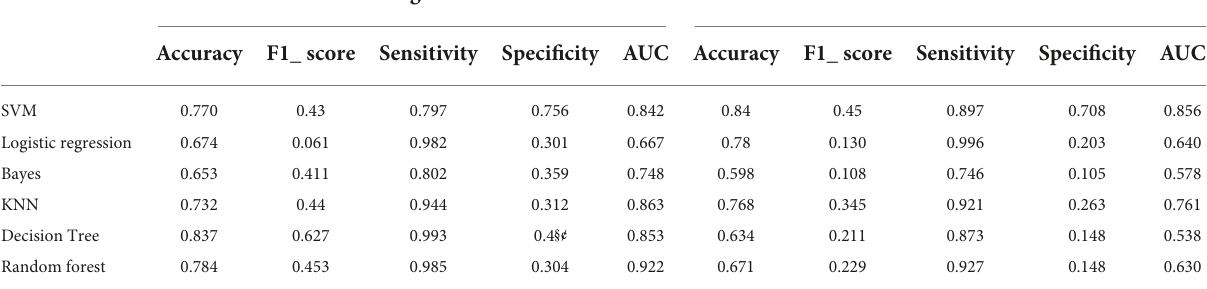
TABLE 3 Discrimination performance of the different model construction methods in the fSAD and non-fSAD